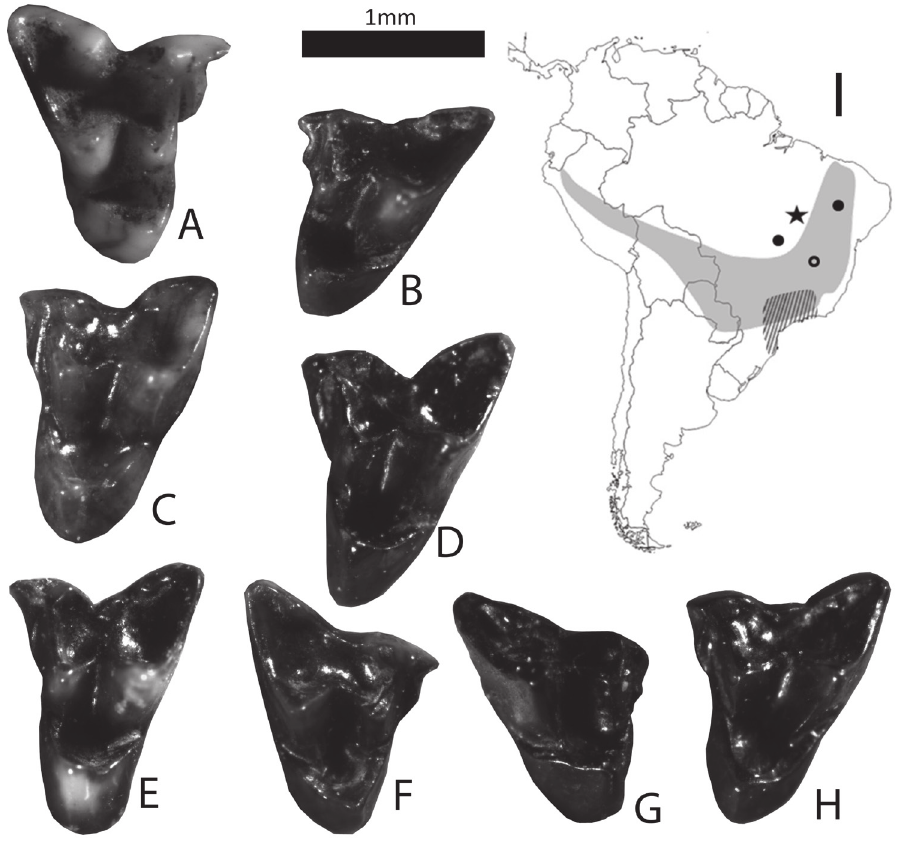
Figure 3 - Selected specimens of Gracilinanus from Gruta dos Moura and its revised geographic distribution for the Pleistocene. A. Gracilinanus agilis right M2 (UNIRIO-PM1211) in occlusal view; B. G. agilis left M2 (UNIRIOPM1118) in occlusal view; C. G. agilis left M2 (UNIRIO-PM1212) in occlusal view; D. G. agilis left M3 (UNIRIOPM1214) in occlusal view; E. G. agilis left M3 (UNIRIO-PM1213) in occlusal view. F. Gracilinanus cf. microtarsus right M2 (UNIRIO-PM1219) in occlusal view; G. G. microtarsus right M3 (UNIRIO-PM1218) in oclusal view; H. G. microtarsus left M2 (UNIRIO- PM1220) in occlusal view. Scale 1mm. I. Geographic distribution of G. agilis and G. microtarsus . Gray area is the geographic distribution of the extant G. agilis . Area with vertical lines is the geographic distribution of the extant G. microtarsus . Black star marks the Gruta dos Moura cave locality. Black circles mark Pleistocene records of G. agilis . Open circle mark Pleistocene records for both G. agilis and G. microtarsus. (Gardner 2008, Winge 1893, Salles et al. 1999, Cartelle 1999, Hadler et al.